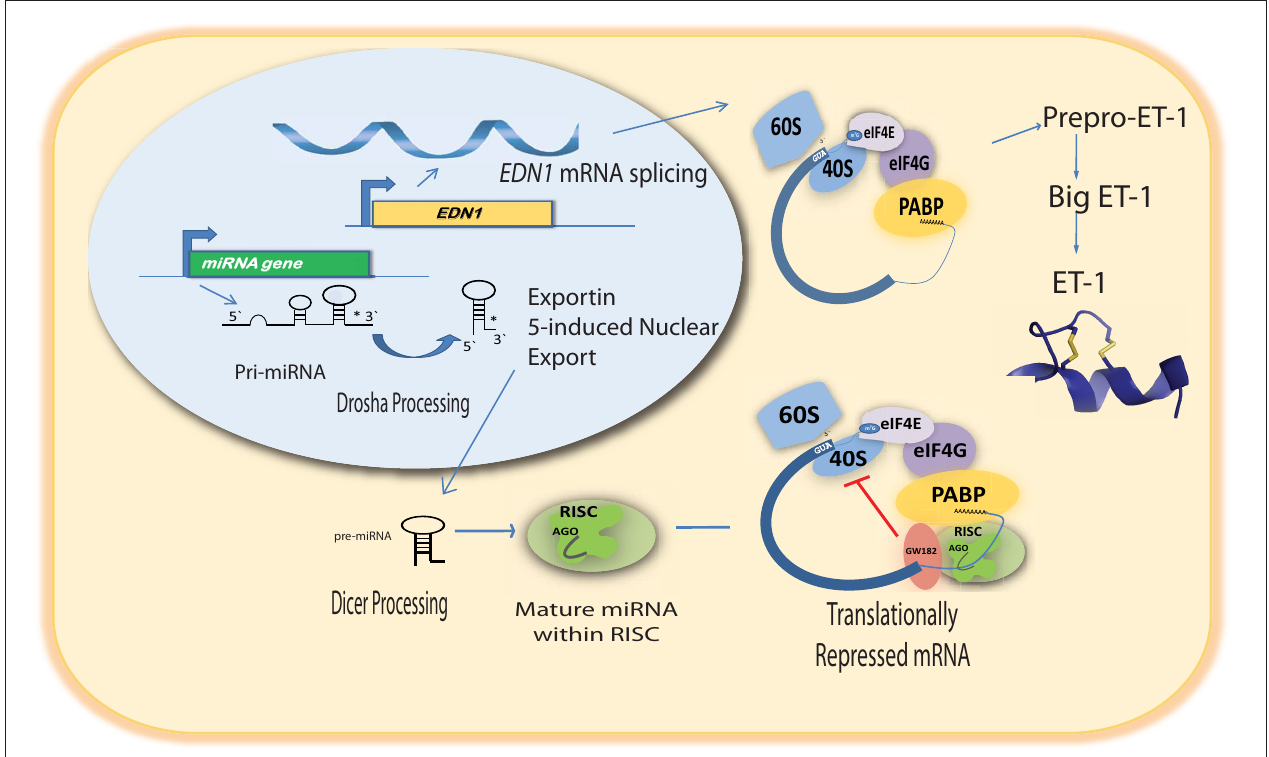
FIGURE 1 | Pathway of miRNA-mediated action on EDN1